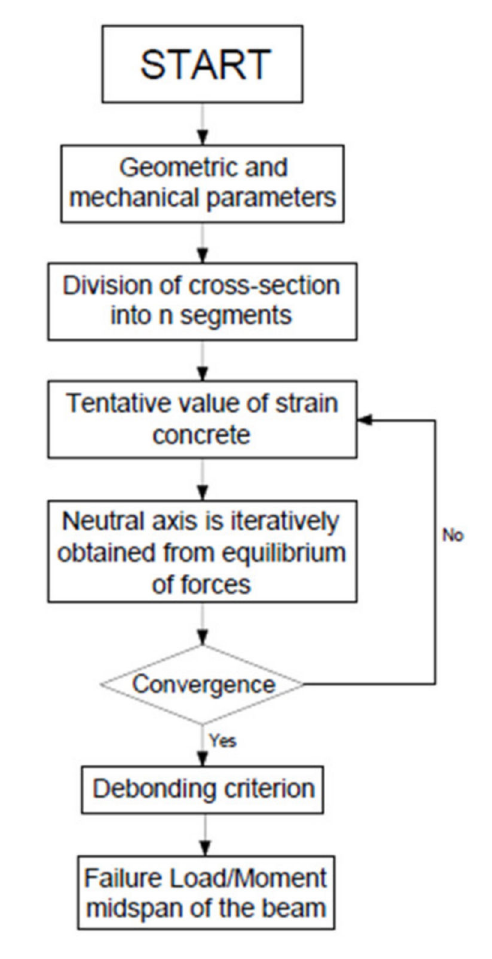
Figure 7. Flowchart of the numerical